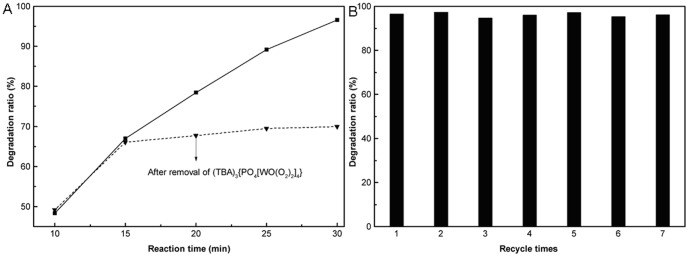
The catalytic activity of the filtrate and the catalyst.The filtrate (A) and the catalyst (B), 0.0125 mmol (TBA)3{PO4[WO(O2)2]4}, 1 mL H2O2, 65°C.